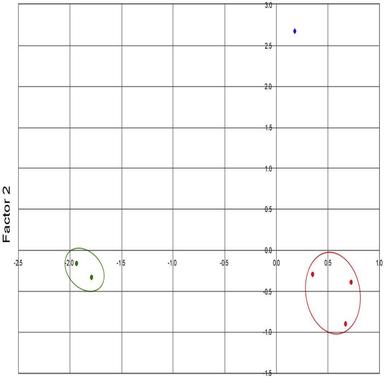
Micro-XRF mapping of sample 4.